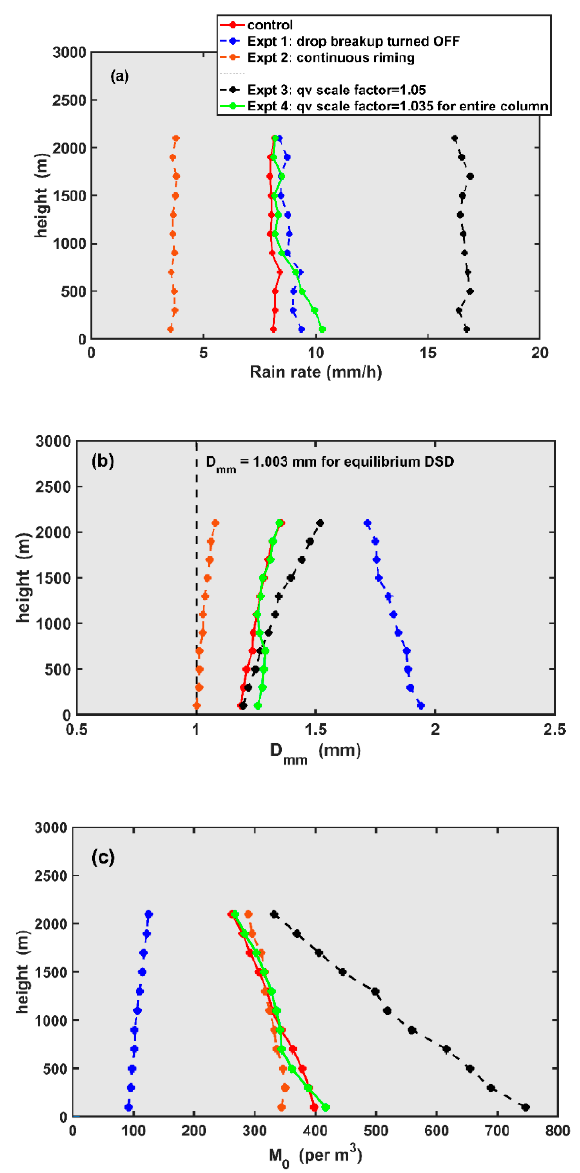
Figure 9. Height profiles from control run and experiments 1–4 averaged over 200 m layers from 0–200, 200–400 m, . . . , up to 2000–2200 m. The ordinate data points refer to the center height of the layers. ( a ) rain rate, ( b ) mean mass diameter, and ( c ) number